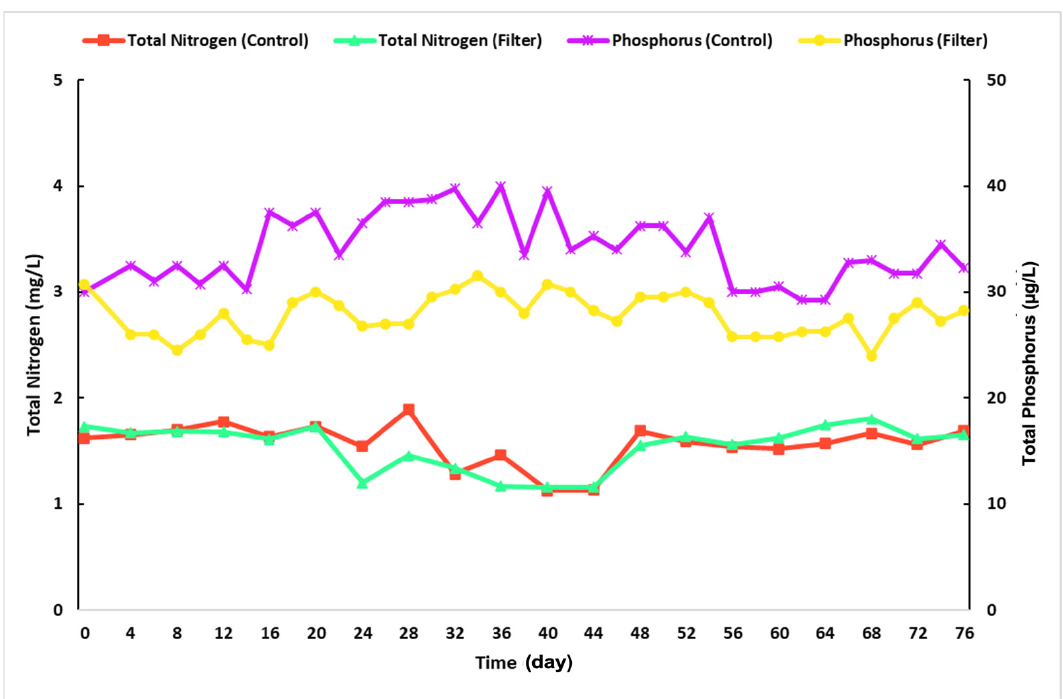
Figure 13. TP concentrations (µg/L) and TN concentrations (mg/L) for the 2020 summer in situ experiment.